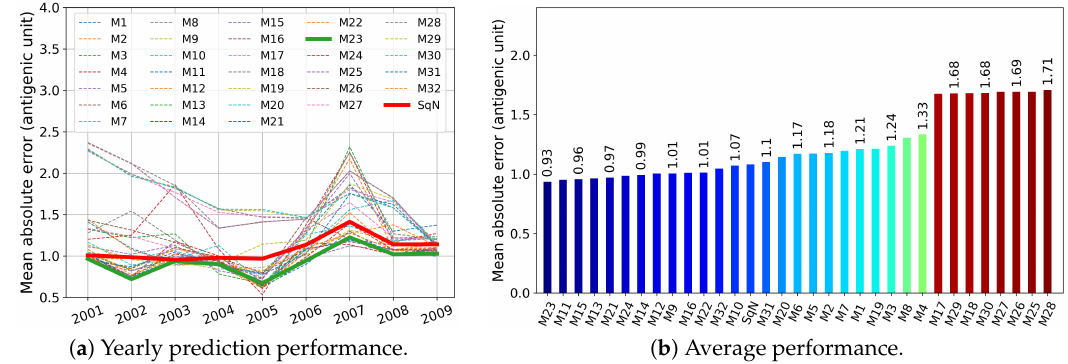
Figure 9. Experiment T all , where all models were trained on the unrestricted prehistory.